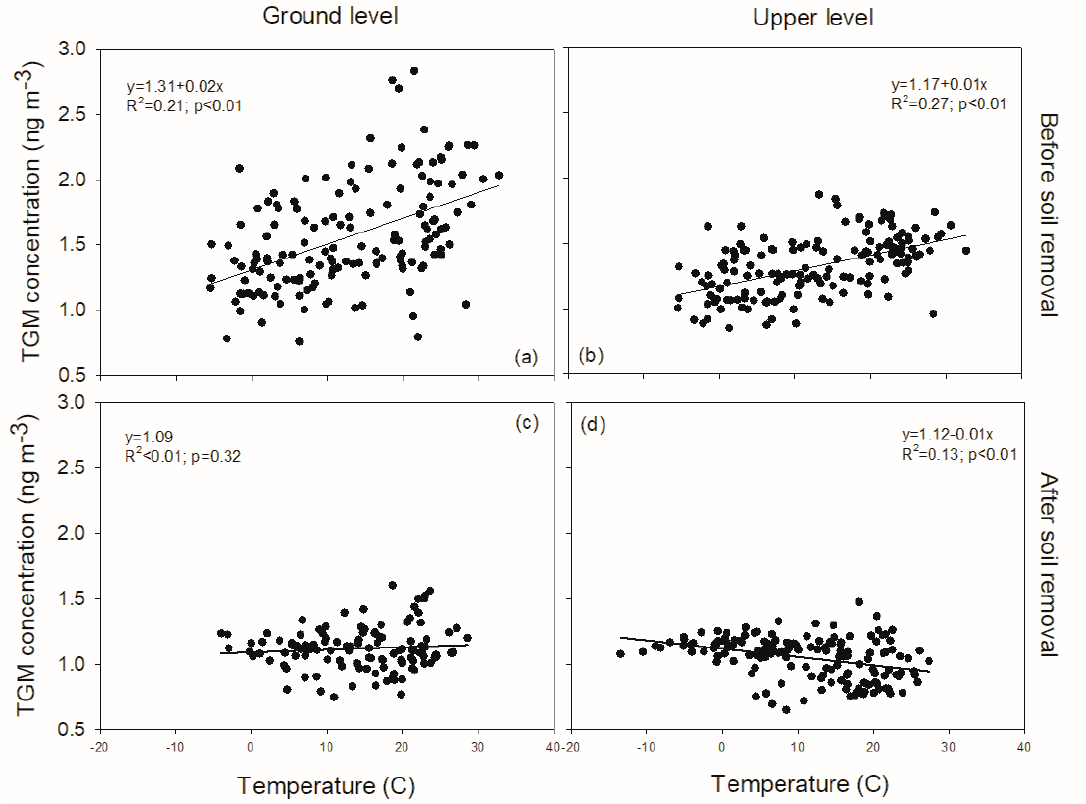
Figure 5. Relationships of TGM concentration with air temperature at ground level ( a , c ) and at height ( b , d ) before ( a , b ) and after ( c , d ) brownfield